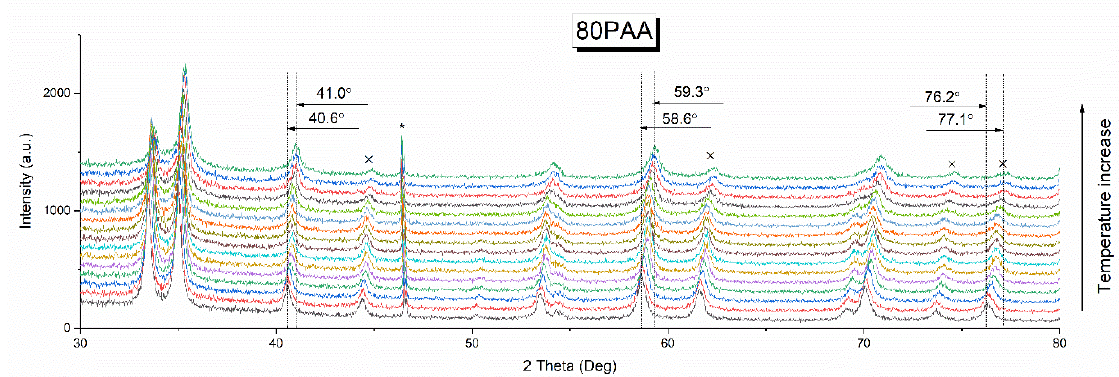
Figure 6. In situ X-ray patterns obtained for the 90PAA sample upon heating in the range 30–330 °C with steps of 10 °C.